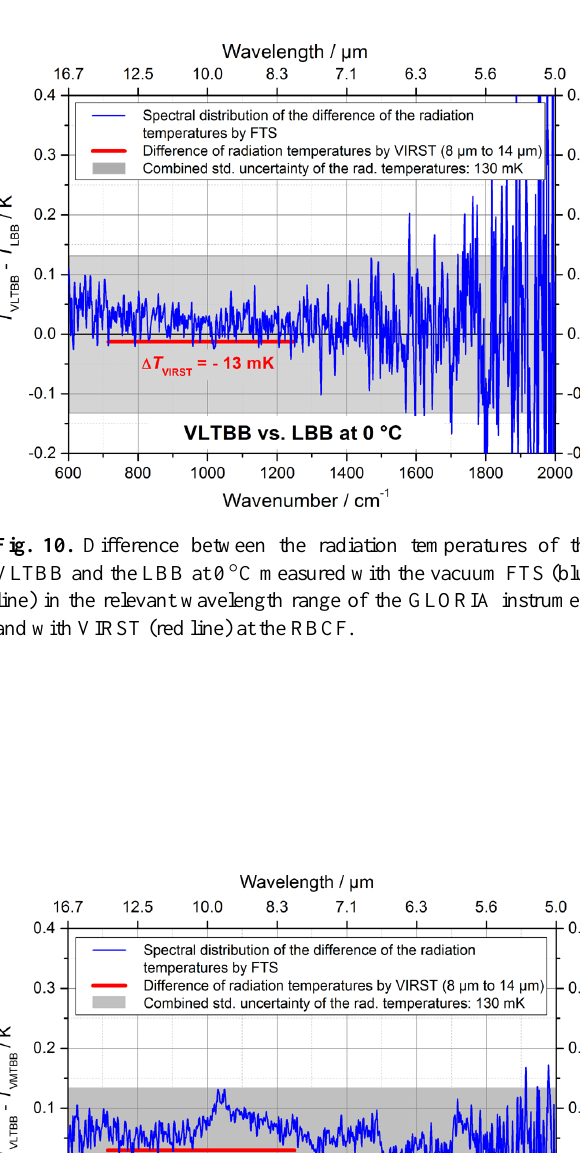
Table 3. Combined uncertainty u ( k = 1) of the radiation tempera- ture of the VLTBB.